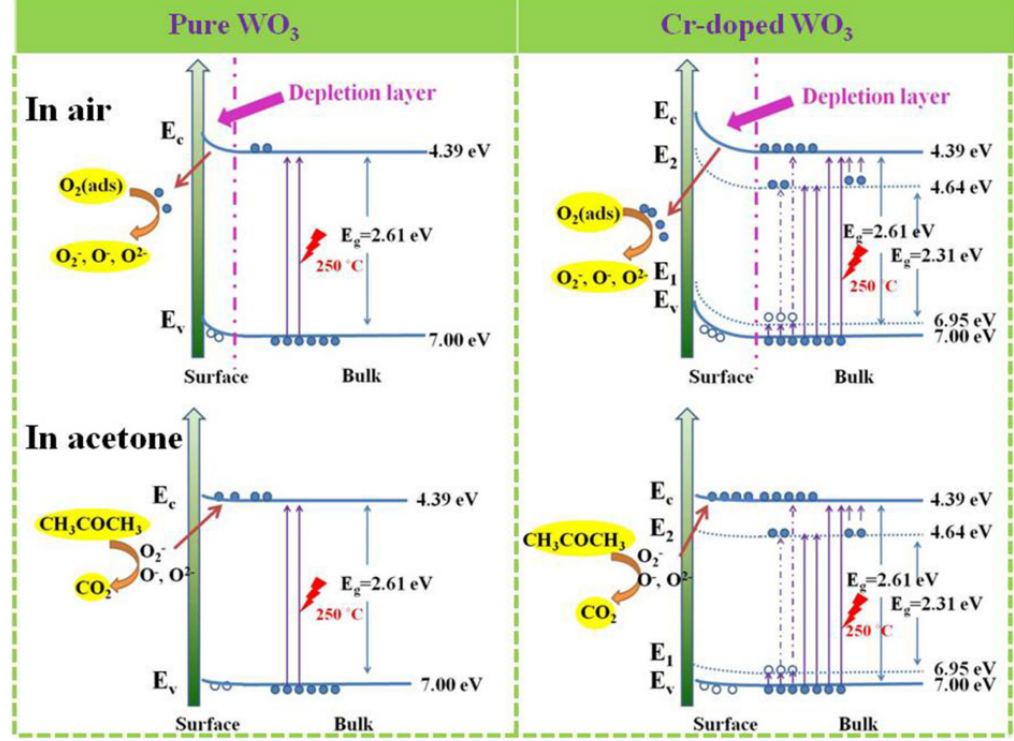
Figure 14. The schematic band diagram of: ( a ) pure WO 3 and ( b ) Cr-doped WO 3 before (up) and after (down) detecting acetone vapor.